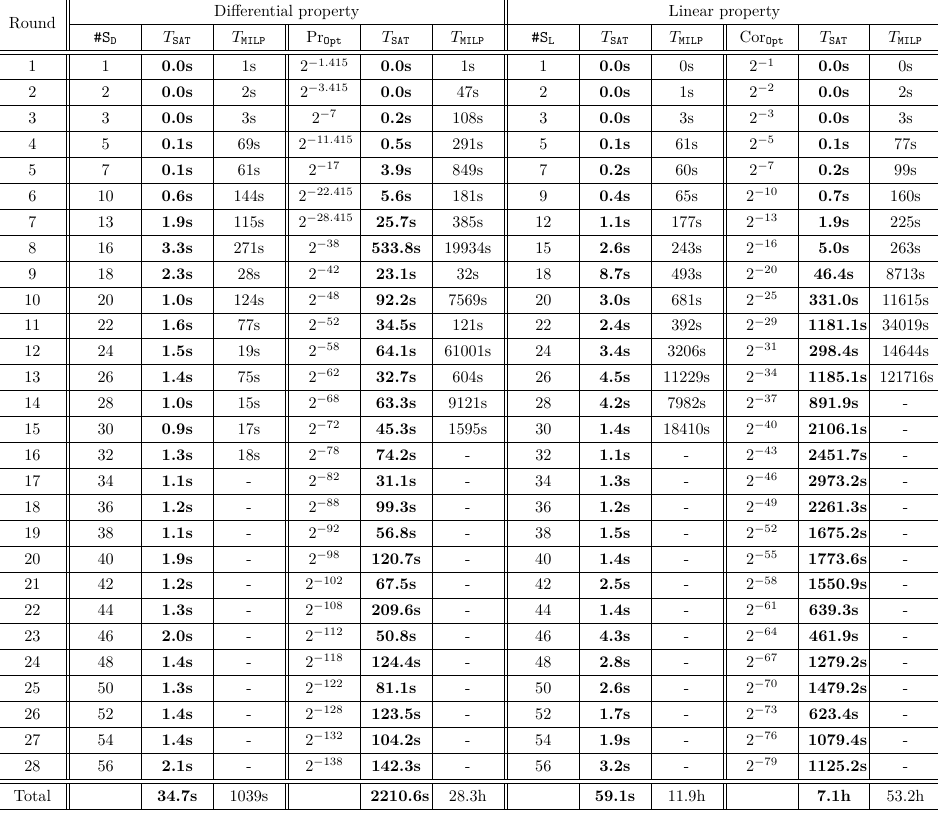
Table 4: Experimental results of GIFT-64